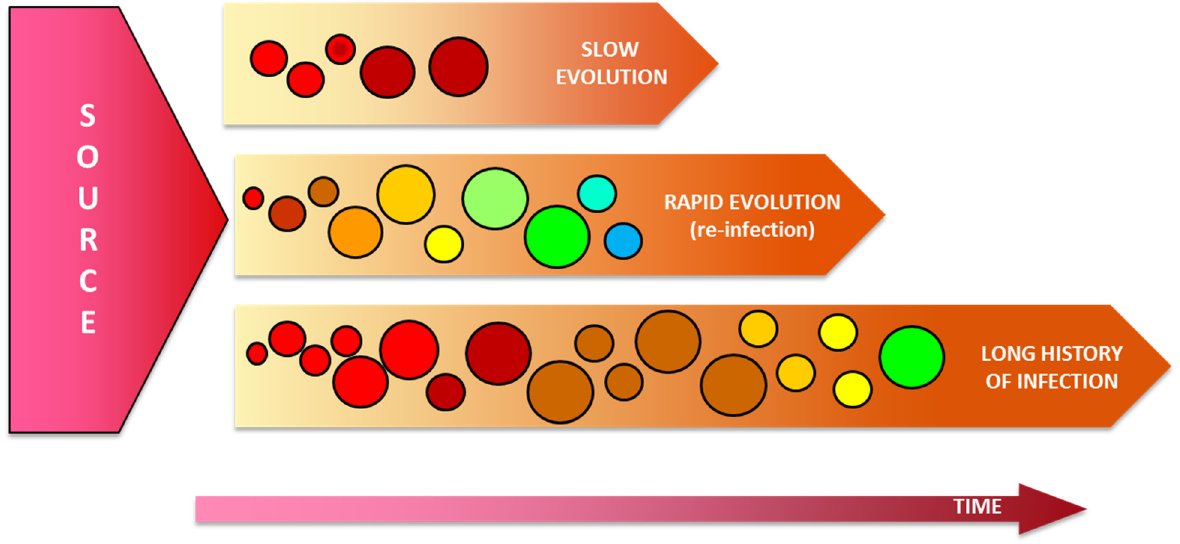
Figure 3. Rapid and slow HCV intrahost molecular evolution. The speed with which HCV evolves in different settings is shown. Viral populations are represented by circles. Viral populations are color coded to represent genetic diversity. The size of circles represents fluctuations in the size of viral populations over time. Generation of viral diversity during the course of infection is illustrated by the change in color of the viral population throughout the